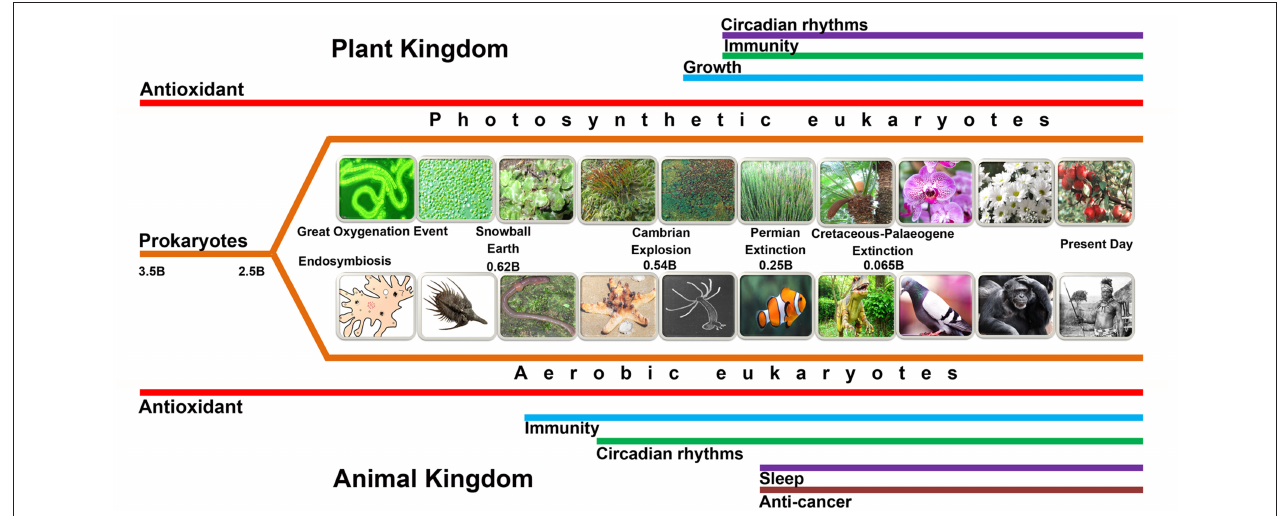
FIGURE 2 | This figure summarizes the possible evolution of various functions (not all are depicted in this figure) of melatonin. Melatonin, predictably, initially evolved in bacteria for the purpose of mitigating oxidative stress, i.e., as an antioxidant (red lines). When the bacteria were phagocytized as food by early eukaryotes, they eventually developed a mutually beneficial association with their hosts and evolved into mitochondria and chloroplasts (see Figure 1 ); this series of events is referred to as endosymbiosis. Subsequently, as evolution proceeded, mitochondria (animals and plants) and chloroplasts (plants) were preserved up until the present day. Thus, mitochondria and chloroplasts of every species that has ever existed or exists today, we theorize, presumably produce melatonin. This presumption is supported by recent findings which show that these organelles, in many cases, possess the necessary synthetic machinery to generate melatonin. Melatonin’s role as an antioxidant in these organelles is of great importance since they are sites of major free radical production. Other colored lines, which are appropriately labeled, identify other functions of melatonin. It is essential that the time frame for these functions, as illustrated by the length of the colored lines, do not accurately depict the time of evolution of these functions. Major events in the history of the Earth are also identified. The “B” following the numbers refers to “billions of years